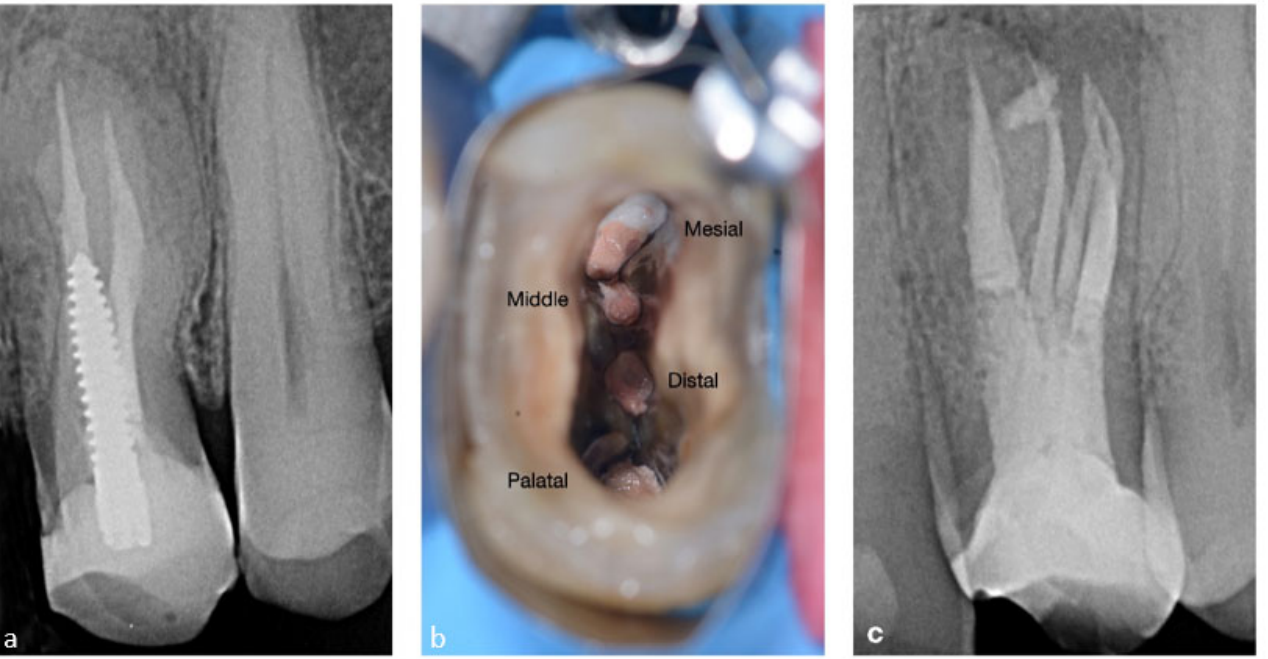
Figure 4. ( a ) Pre ‐ operative view of the premolar, ( b ) post ‐ operative X ‐ ray of the four canals filled Figure 4. ( a ) Pre-operative view of the premolar, ( b ) post-operative X-ray of the four canals filled with gutta ‐ percha ( c ) 1 ‐ year follow ‐ up. with gutta-percha ( c ) 1-year